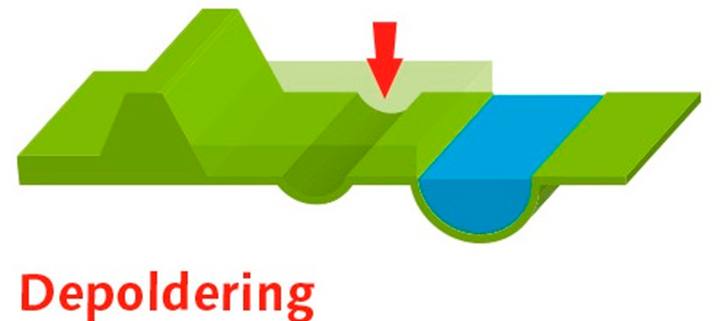
Figure 1. Depoldering. One of the nine methods to make room for the Dutch rivers. Image courtesy Rijkswaterstaat.